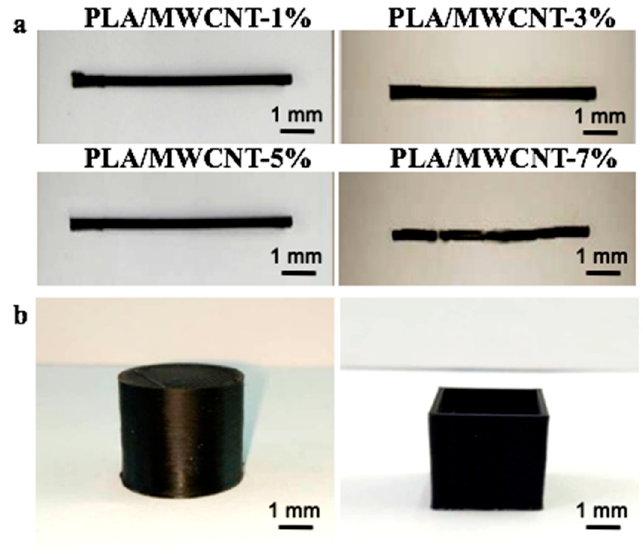
Figure 6. ( a ) Line test of the extruded PLA/MWCNTs samples containing different amounts of MWCNTs; ( b ) Pictures of some products printed with a 0.4-mm nozzle diameter.